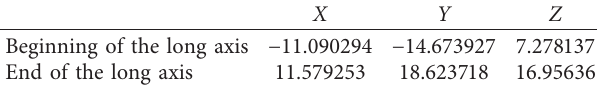
Table 3: The coordinates of the two endpoints of the long axis.